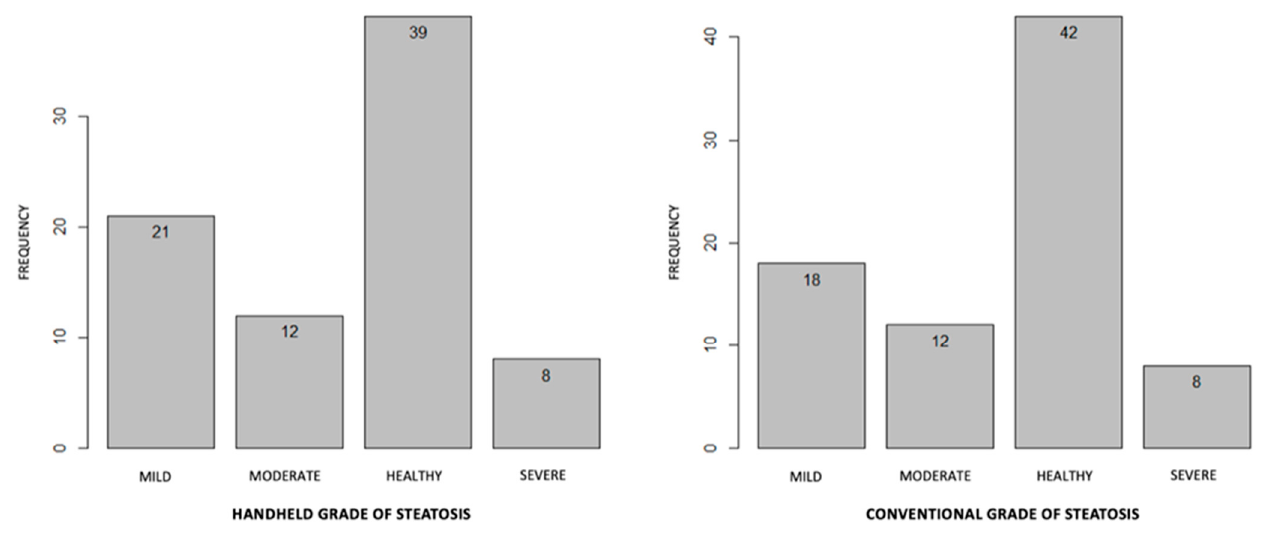
Figure 3. Frequency of degrees of hepatic steatosis with conventional and HHUS methods. Chi- square, p <0.0001.